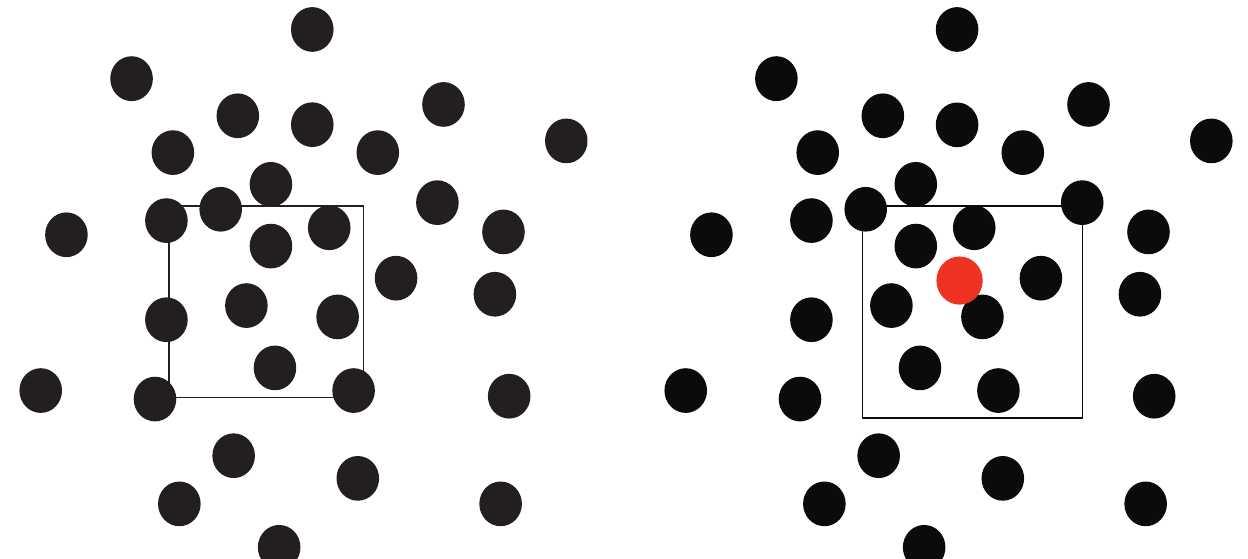
Figure 9: Particle distribution diagram at time t .